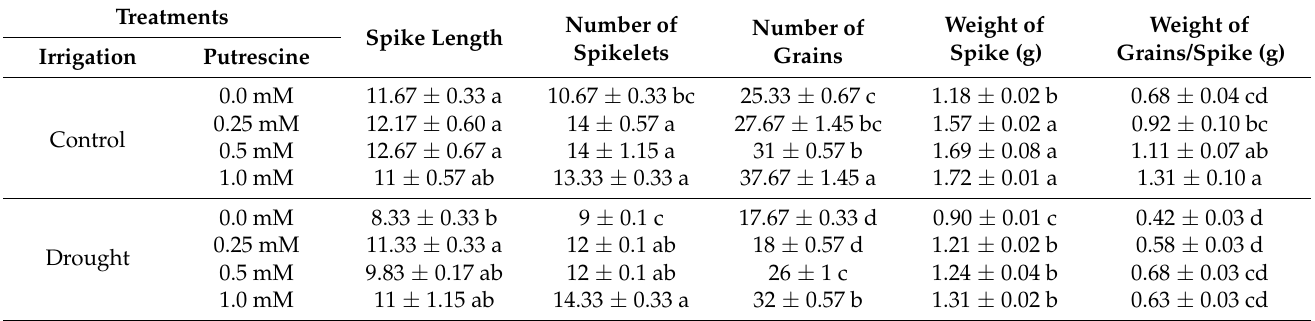
Table 4. The response of yield components of the wheat plant to putrescine, drought stress, and their combination. Values depict the mean and standard error. Different letters indicate different significance between